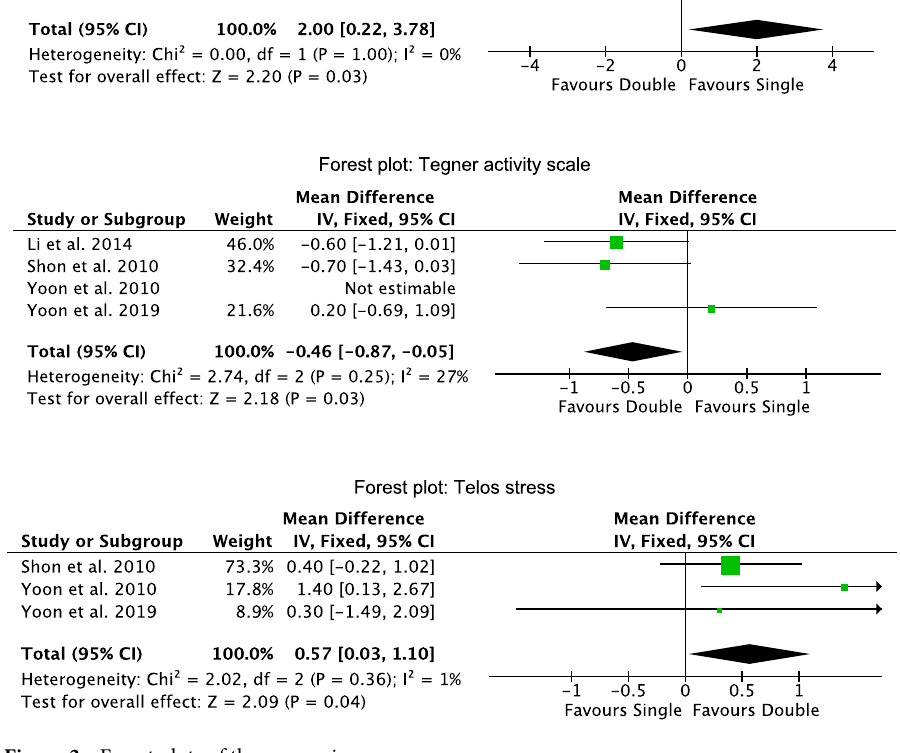
Figure 3. Forest plots of the